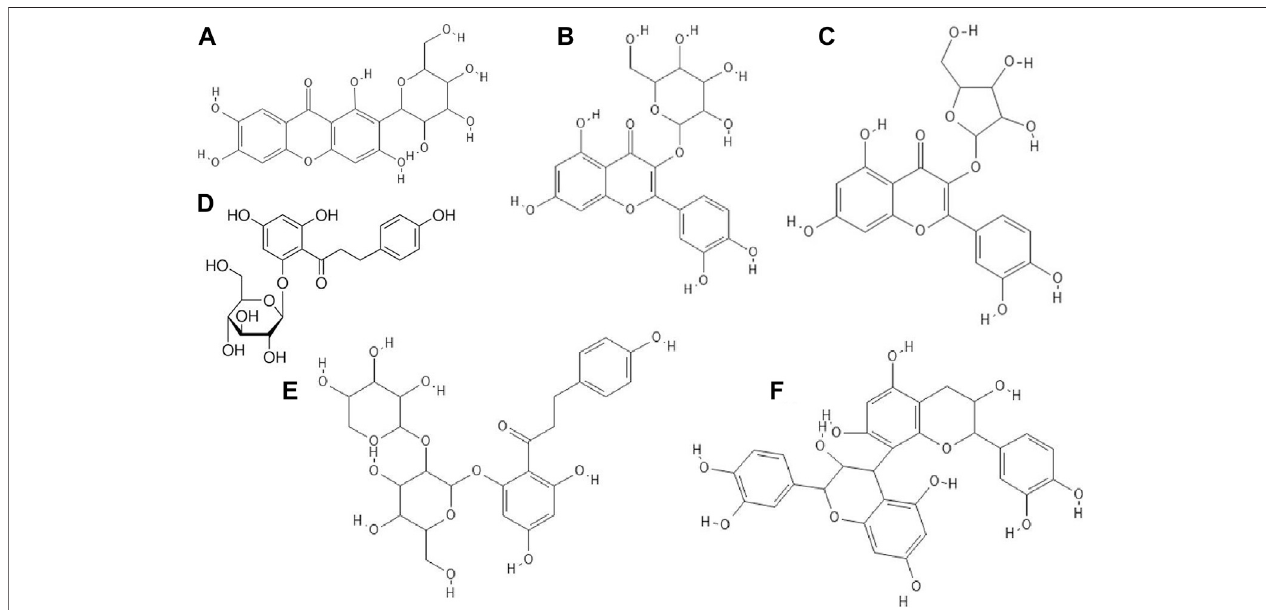
FIGURE6| Thestructuresof:mangiferin(1,3,6,7-TetrahydroxyxanthoneC2- β -D-glucoside, (A) ,hyperin(quercetin3-D-galactoside) (B) ,avicularin(quercetin3-O- α -L-arabinofuranoside) (C) , phloridzin (phloretin 2 ′ - β -D-glucopyranoside), (D) , phloretin, (E), procyanidin B2 (F) .